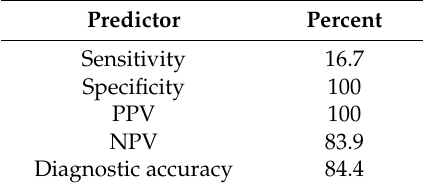
Table 4. The diagnostic value of preoperative CT scan in the vascular invasion of the tumor.